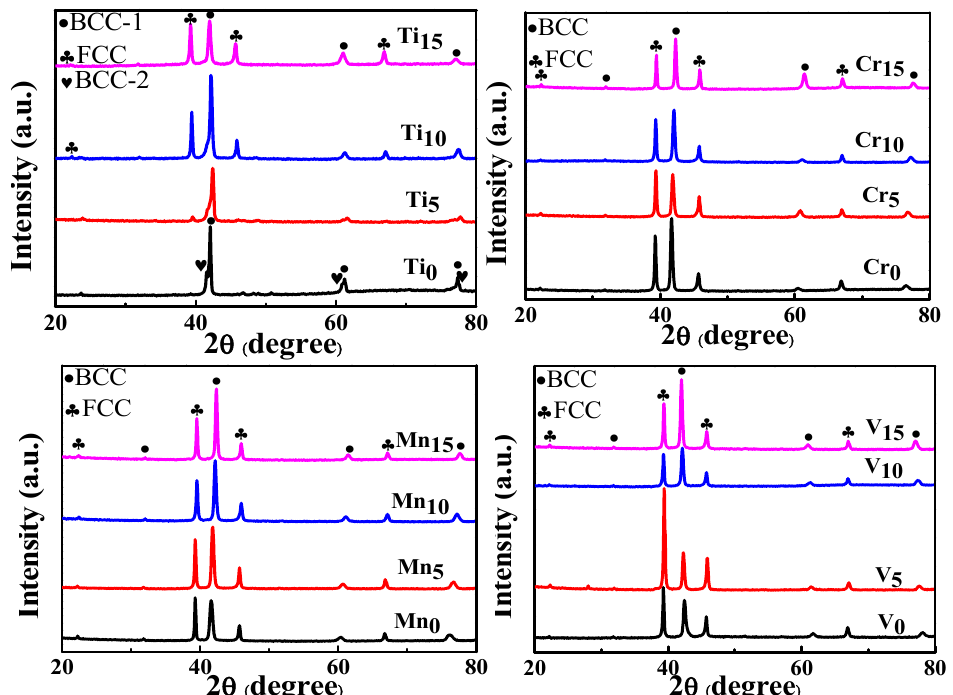
Figure 2. XRD patterns of the Al 50 –Ti–Cr–Mn–V alloys. Table 1. Mechanical compressive properties of the Al 50 –Ti–Cr–Mn–V alloys.